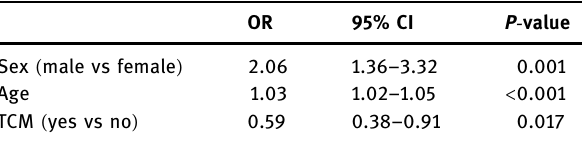
Table 2: Binary logistic regression analysis of